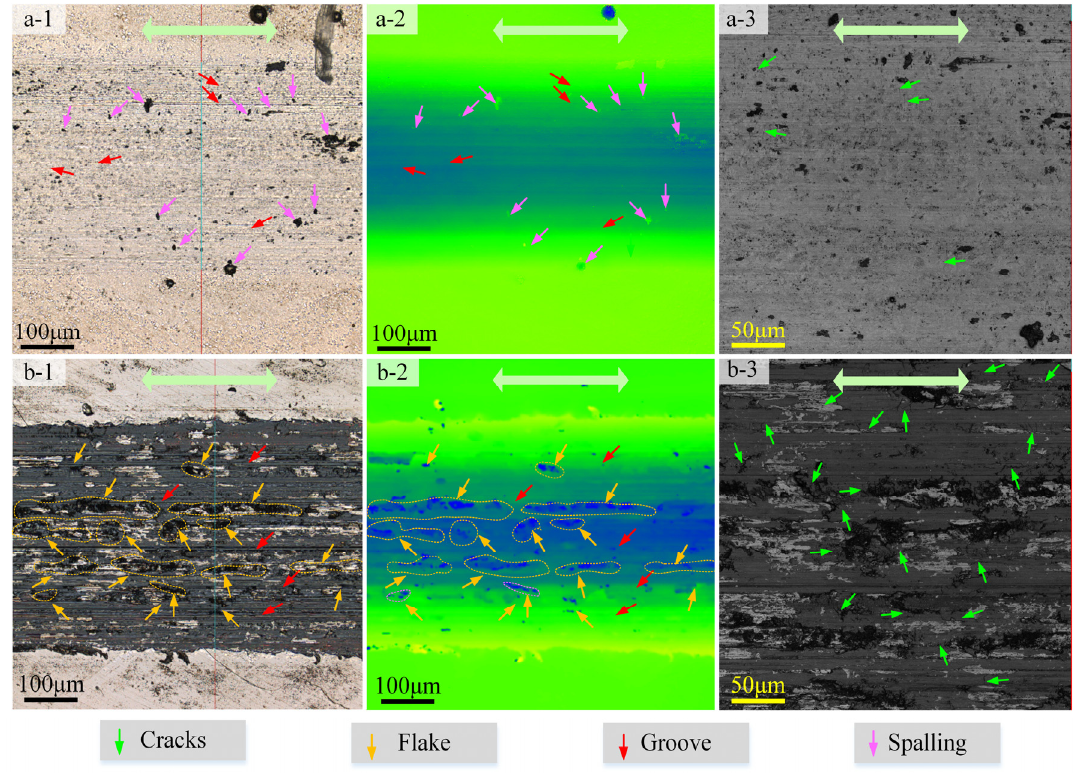
Figure 19. Optical images of worn surfaces ( a-1 ) 2D worn surface morphologies of repaired gear teeth, ( a-2 ) height graph of a-1, ( a-3 ) enlarged view of a-1. ( b-1 ) 2D worn surface morphologies of 20CrMnTi substrate, ( b-2 ) height graph of b-1, ( b-3 ) enlarged view of